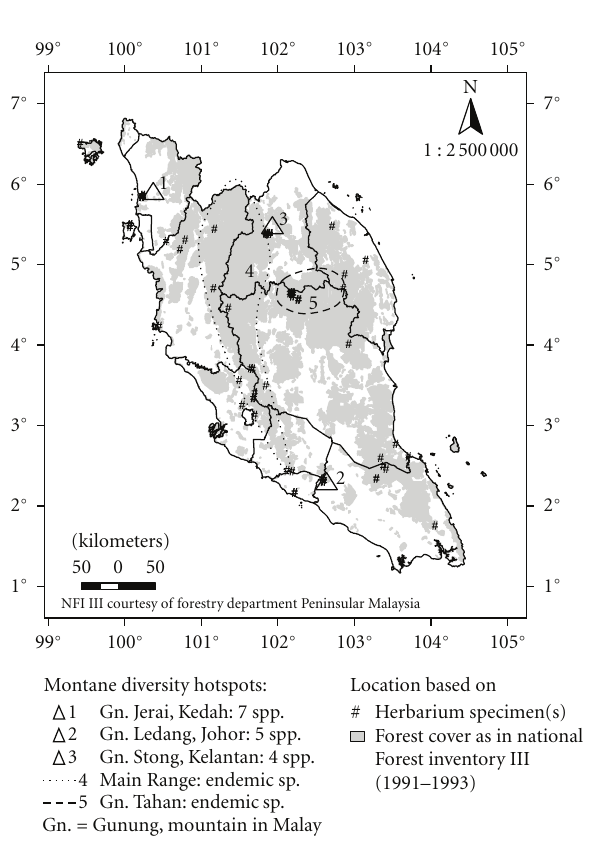
Figure 3: Distribution of Utricularia in mountainous habitats in Peninsular Malaysia ( ≥ 300 m